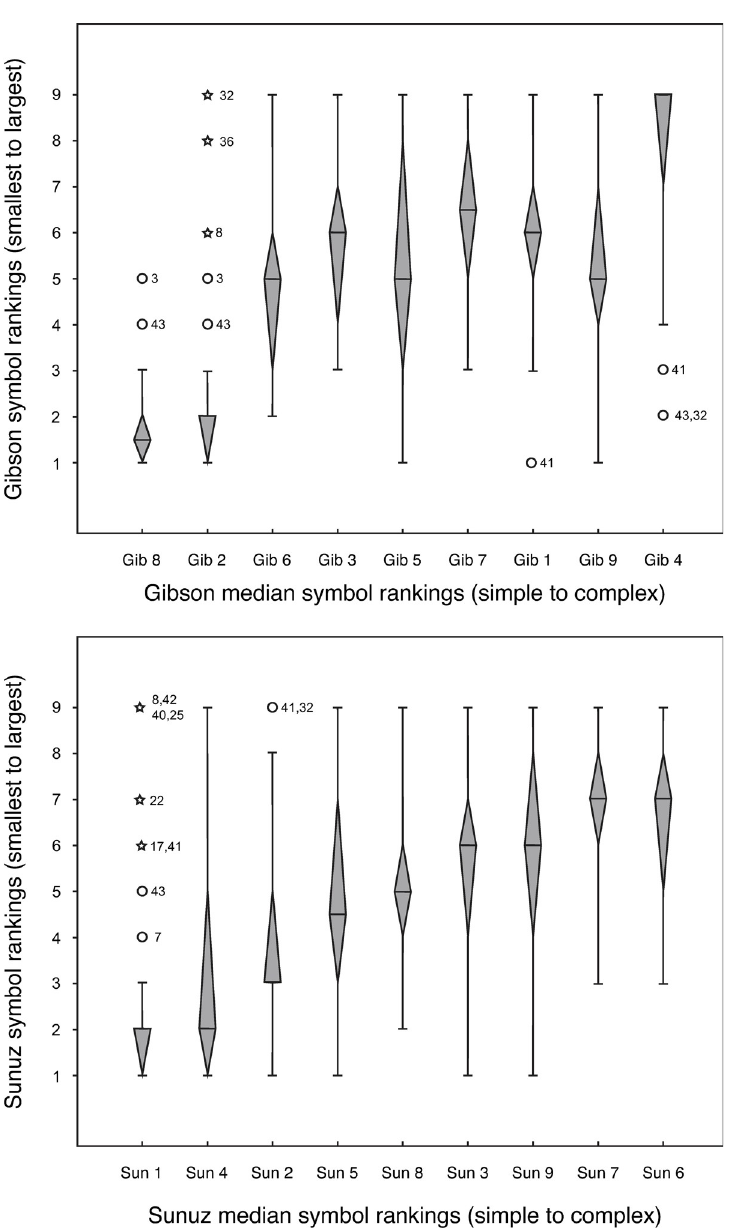
Fig 1. Box plots displaying median small to large symbol rankings (y-axis) ordered by the median simple to complex ranking (x-axis) for the Gibson symbols (top) and Sunu´z symbols (bottom). Regular outliers are denoted by open circles and represent 1.5 times the interquartile range. ‘Extreme’ outliers are denoted by stars and represent 3 times the interquartile range. The specific numbers next to outliers correspond to individual participants.